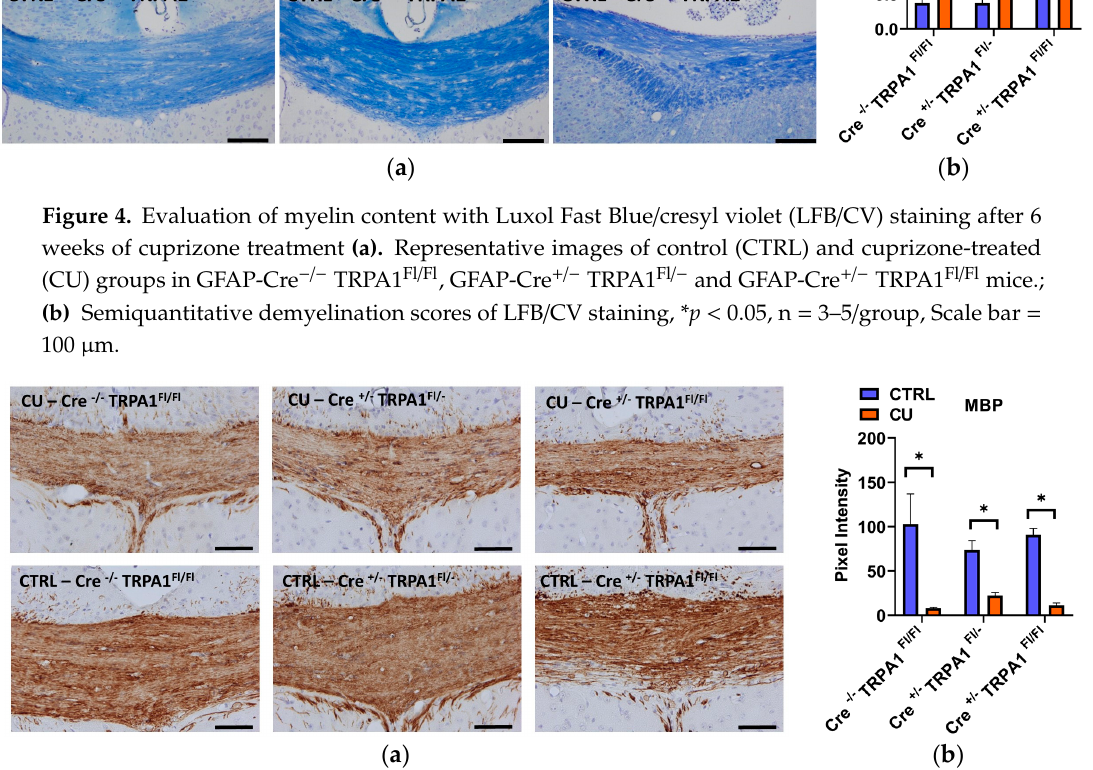
Figure 5. Evaluation of myelin content with myelin basic protein (MBP) immunohistochemistry after 6 weeks of cuprizone treatment (a). Representative images of control (CTRL) and cuprizone-treated (CU) groups in GFAP-Cre − / − TRPA1 Fl / Fl , GFAP-Cre +/ − TRPA1 Fl / − and GFAP-Cre +/ − TRPA1 Fl / Fl mice.; (b) Pixel intensities of diaminobenzidine staining in the middle part of the corpus callosum in each group, * p < 0.05, n = 3 – 5/group, Scale bar = 100 µm.